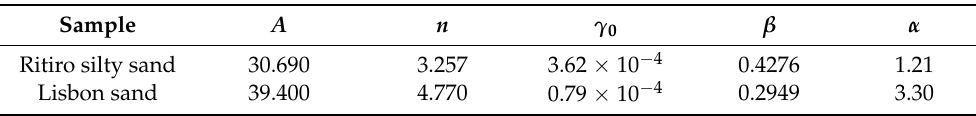
Table 6. Fitting parameters o for predicting shear modulus of liquefiable sand in Ritiro and Lis- bon